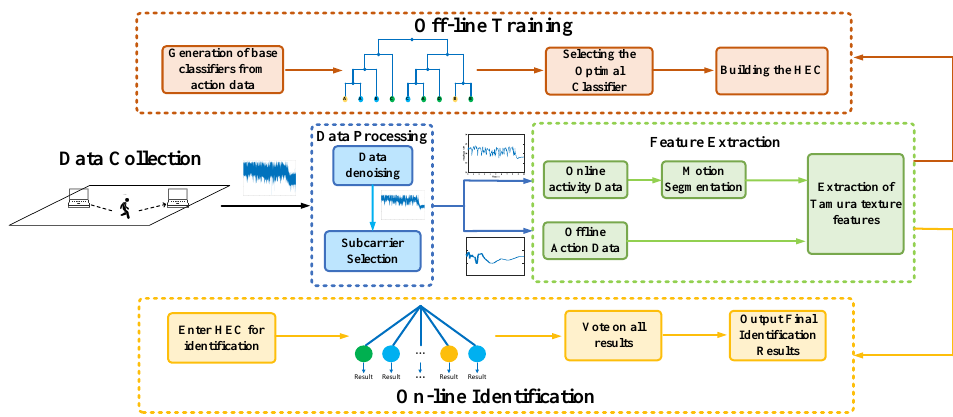
Figure 4. System architecture of Wi-CAS.